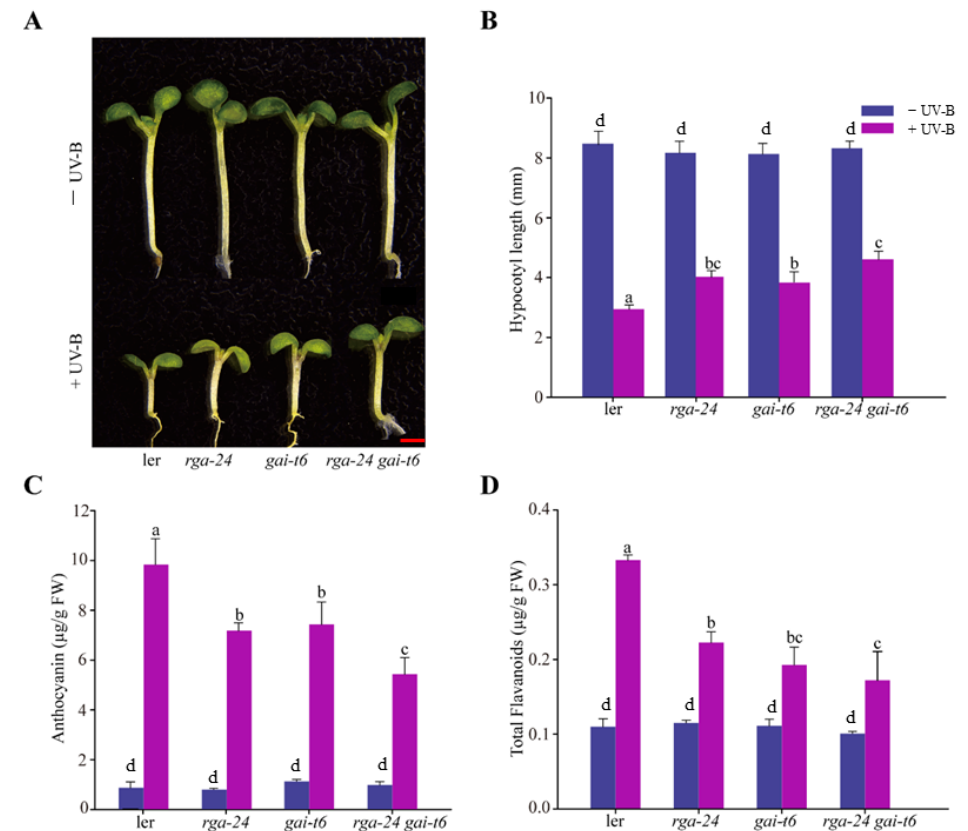
Figure 2. DELLA promotes hypocotyl elongation and the synthesis of flavonoid under UV-B radiation. ( A ) Images of the Ler rga-24 , gai-t6 , and rga-24 gai-t6 seedlings. Bar = 1 mm. ( B ) The hypocotyl lengths of the indicated genotypes. ( C ) Anthocyanin content. ( D ) Flavonoid content. All the above indicated seedlings were transferred to UV-B radiation of 0.6 W/m 2 for 4 days after growing under white light for 2 days, and then the content of anthocyanin and flavonoid was measured. ‘FW’ indicated fresh weight. Error bars indicate SE ( n ≥ 3). The letters ‘a’ to ‘c’ indicate statistically significant differences between the indicated seedlings grown in the presence of UV-B radiation, as determined by Tukey’s least significant difference test ( p < 0.05).